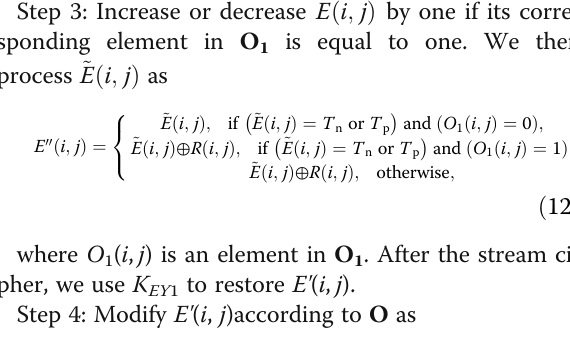
Table 5 Comparison among four methods in terms of SSIM, PSNR, and ER for UCID